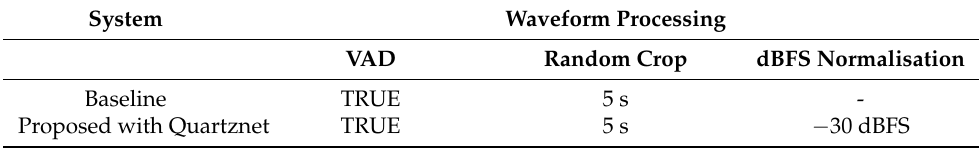
Table 5. Waveform processing details for baseline and QuartzNet-based